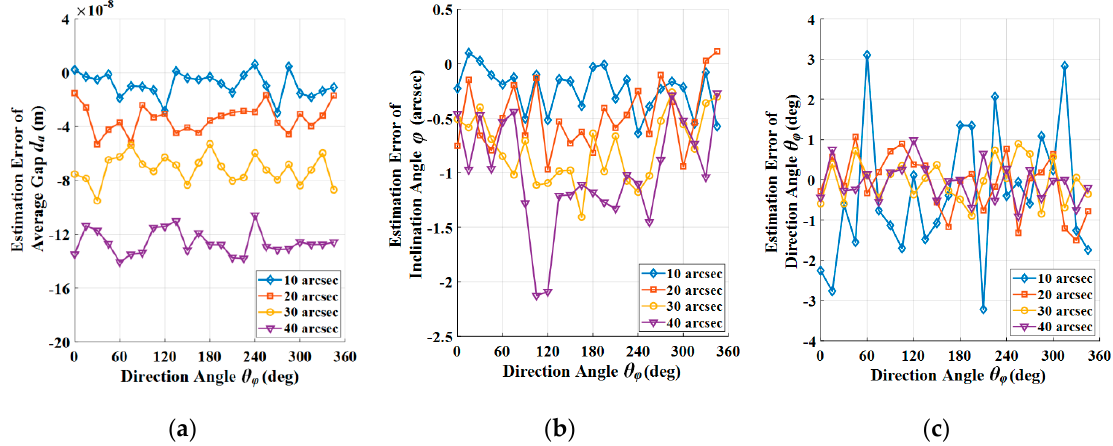
Figure 13. Estimation error of assemble errors and parameters: ( a ) Estimation error of average gap with typical inclination angle and different direction angle; ( b ) Estimation error of inclination angle with typical inclination angle and different direction angle; and, ( c ) Estimation error of direction angle with typical inclination angle and different direction angle.